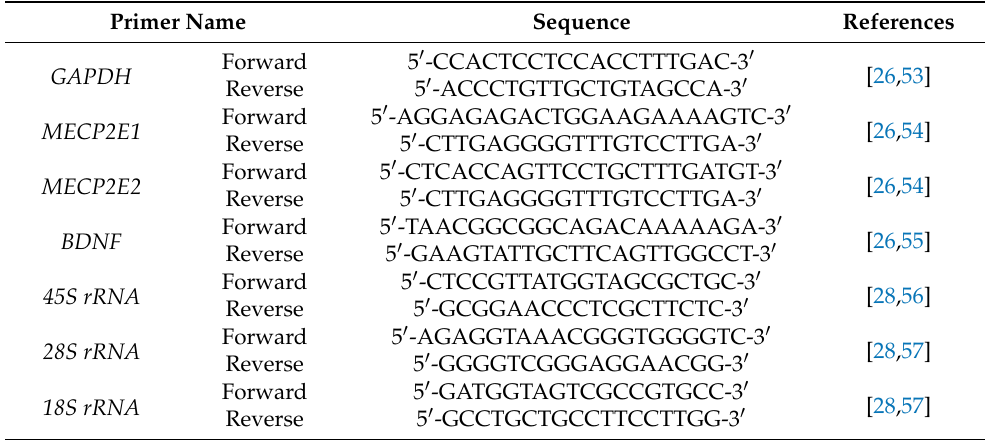
Table 1. Primer sequences used for qRT-PCR in this